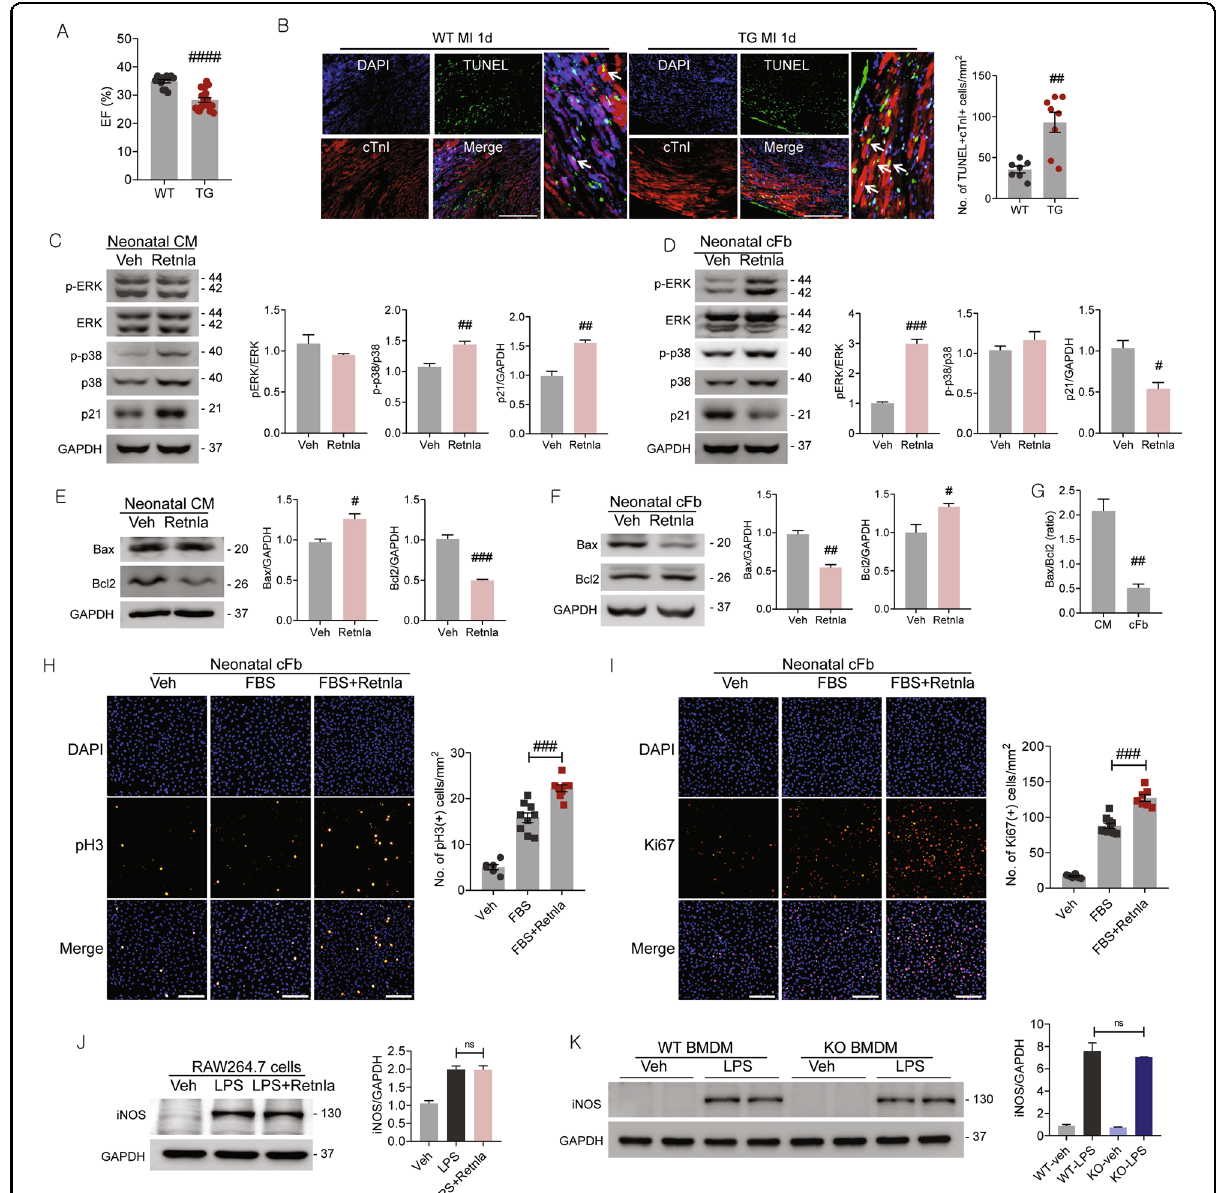
Fig. 3 Effects of Retnla protein treatment on cardiomyocytes, cardiac fi broblasts, and macrophages. A Cardiac function was assessed by echocardiography in wild type (WT, n = 13) and Retnla transgenic (TG) mice ( n = 20) after myocardial infarction (MI). B Cardiomyocyte apoptosis (white arrows) in the peri-infarct area was determined by TUNEL staining. cTnI cardiac troponin I. (WT; n = 7, KO; n = 8). Scale bar, 200 μ m. C , D Phosphorylation of stress-activated ERK and p38 and cell cycle arrest-related proteins p21, and were assessed in neonatal rat cardiomyocytes (CM) or neonatal rat cardiac fi broblasts (cFb) by western blotting. Cells were treated with veh or Retnla (500 ng/mL) for 24 h. E , F Expression of pro-apoptotic Bax and antiapoptotic Bcl2 was determined by western blot analysis in cardiomyocytes and cardiac fi broblasts treated with vehicle (veh) or Retnla (500ng/mL) protein for 24 h. G The ratios of Bax to Bcl2 were calculated in cardiomyocytes and cardiac fi broblasts and showed signi fi cant difference. H , I Proliferation of cardiac fi broblasts were induced with FBS with or without Retnla treatment for 24 h. Proliferating cell markers, phosphorylated histone H3 (pH3) and Ki67, were used and quanti fi ed by counting pH3( + ) cells (veh; n = 6, FBS; n = 9, FBS + Retnla; n = 8) and Ki67( + ) cells (veh; n = 6, FBS; n = 10, FBS + Retnla; n = 7). J Induction of inducible nitric oxide synthase (iNOS), a pro-in fl ammatory marker, was assessed in RAW264.7 cells stimulated with lipopolysaccharide (LPS, 100 μ g/mL) for 24 h in the presence of Retnla (500 ng/mL). K Bone marrow-derived macrophages (BMDMs) were derived from WT mice and Retnla KO, and stimulated with LPS (100 μ g/mL) for 24 h. Induction of iNOS was compared by western blot. Data are represented as mean ± SEM. # P < 0.05, ## P < 0.01, ### P < 0.001 (by Student ’ s t test or one-way ANOVA with Bonferroni ’ s multiple comparisons